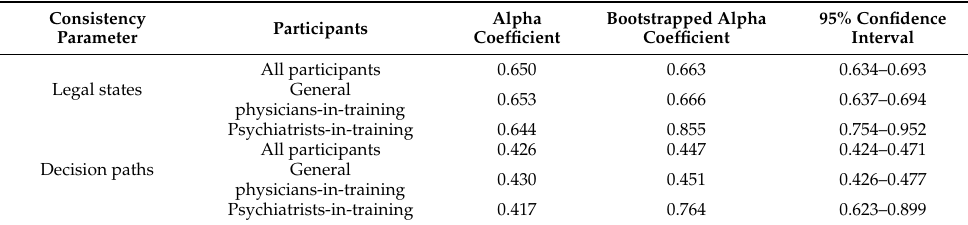
Table 7. Krippendorff’s alpha values for the legal states and the decision